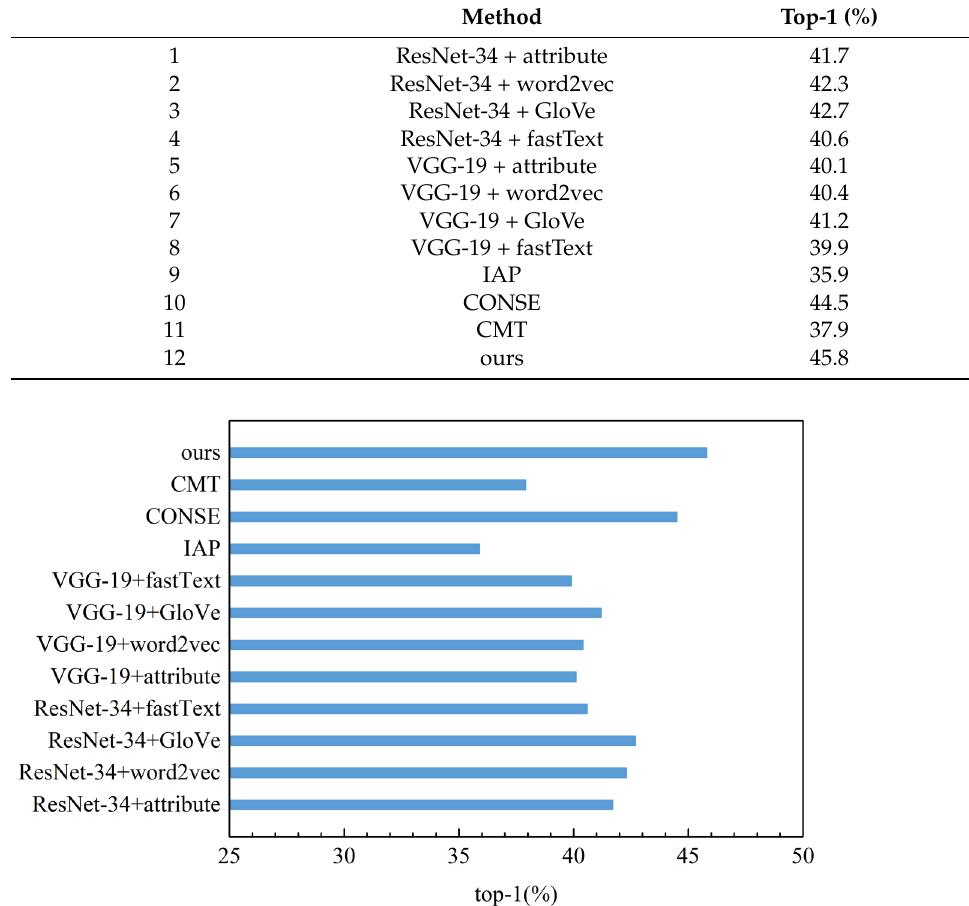
Table 5. Image classification results of different methods.